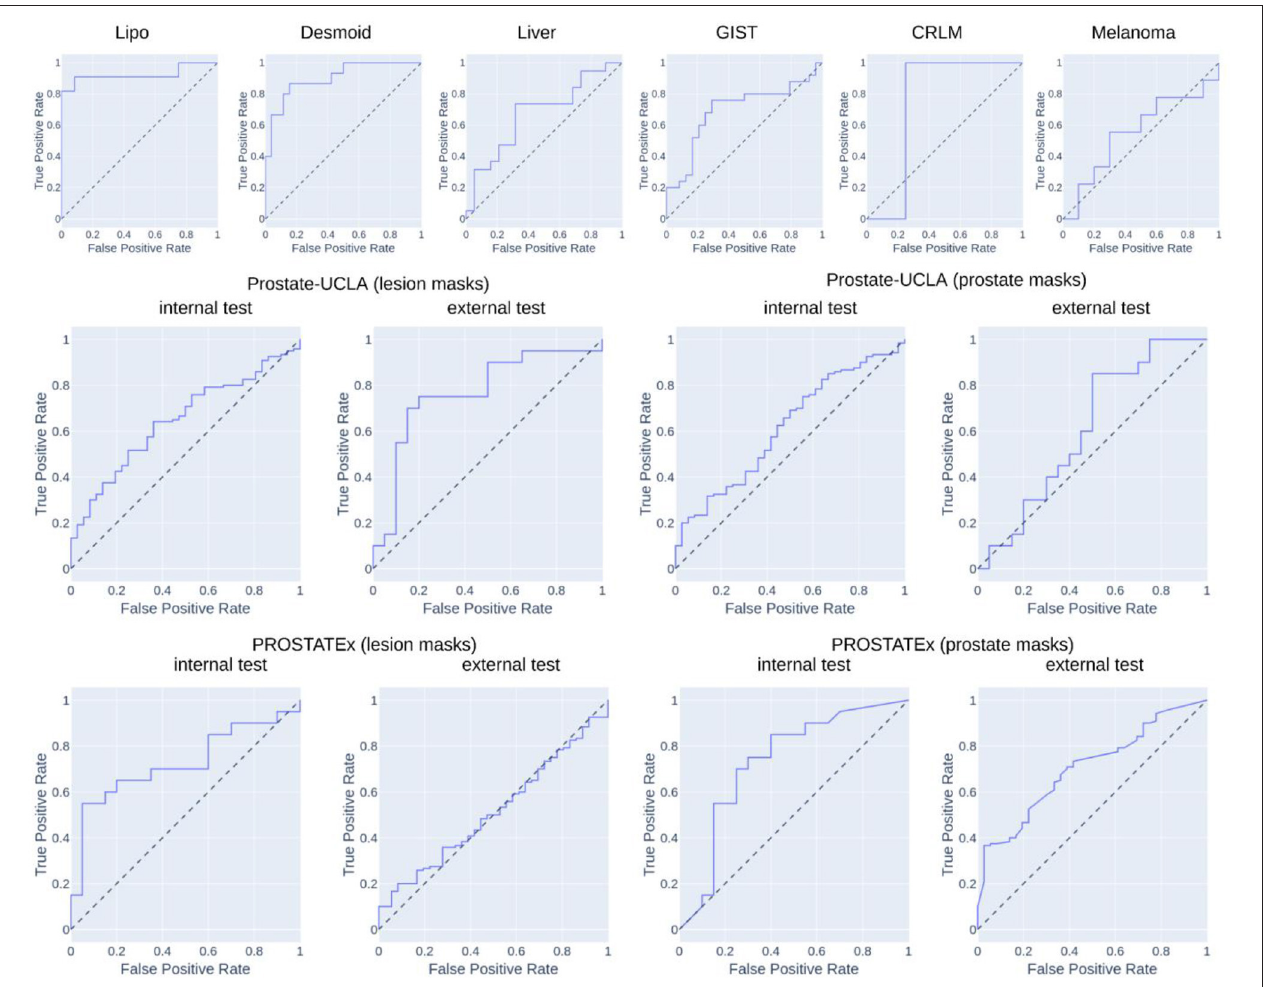
FIGURE 4 | Results of ROC